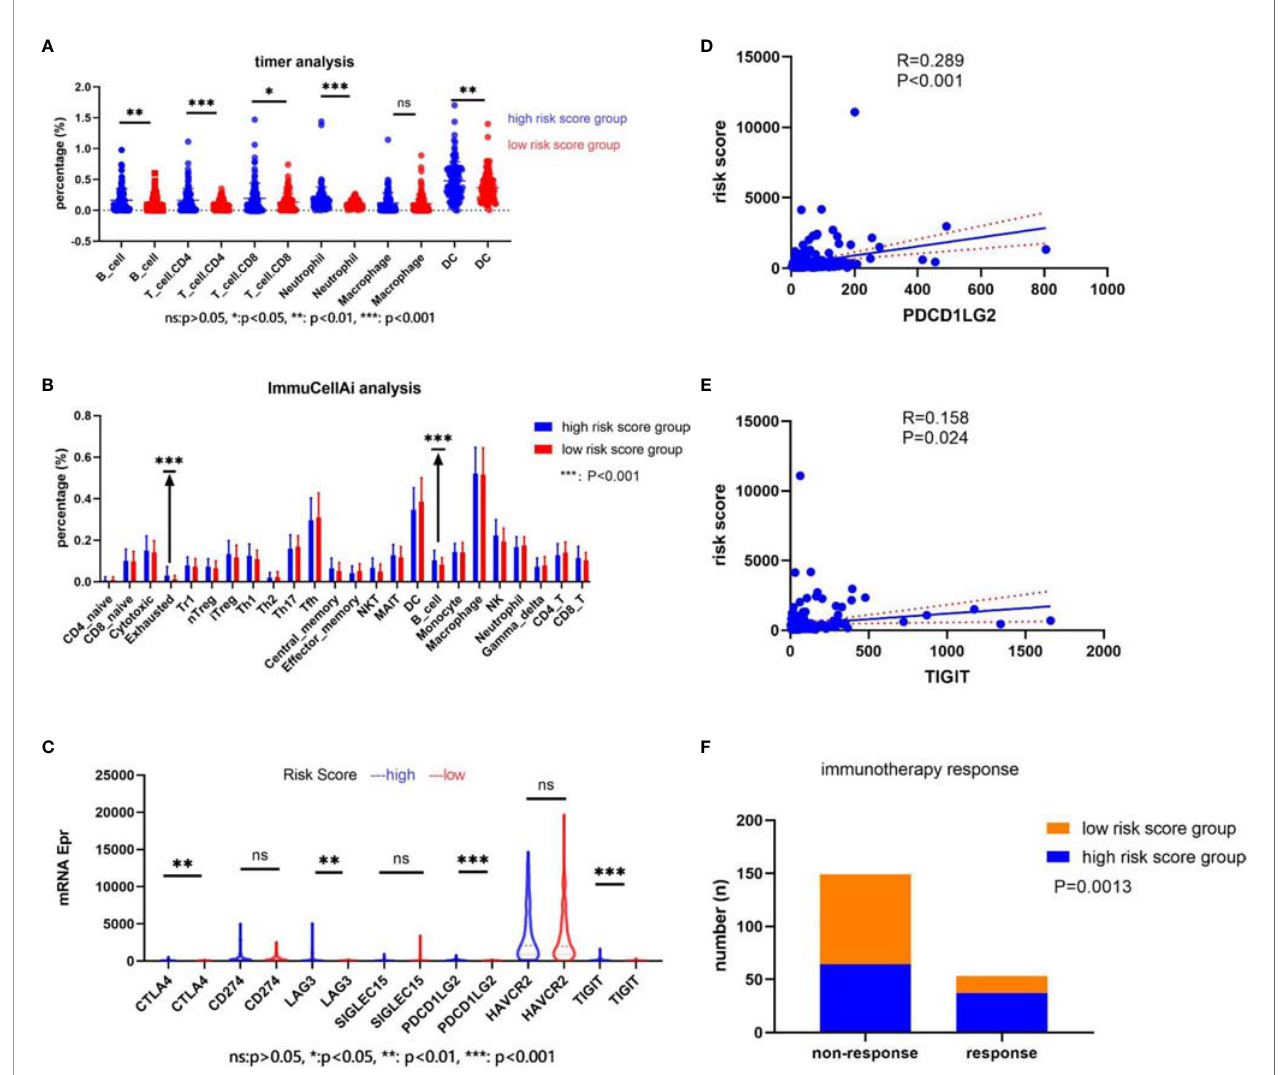
FIGURE 7 | The relationship between the risk score and immune cell component, the immune-related genes ’ expression, and the immunotherapy response. (A) The immune cell component in the web of timer; (B) the immune cell component in the web of ImmuCellAI; (C) the immune-related genes ’ expression in two groups; (D, E) the correlation between the risk score and the immune-related genes; (F) the immunotherapy